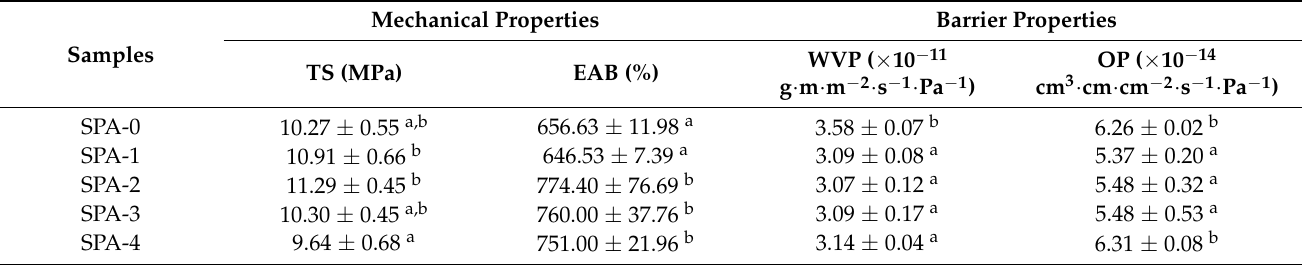
Table 1. Mechanical and barrier properties of starch/PBAT antibacterial films loaded with different levels of AgNPs@SiO 2 . Mechanical Properties Barrier Samples